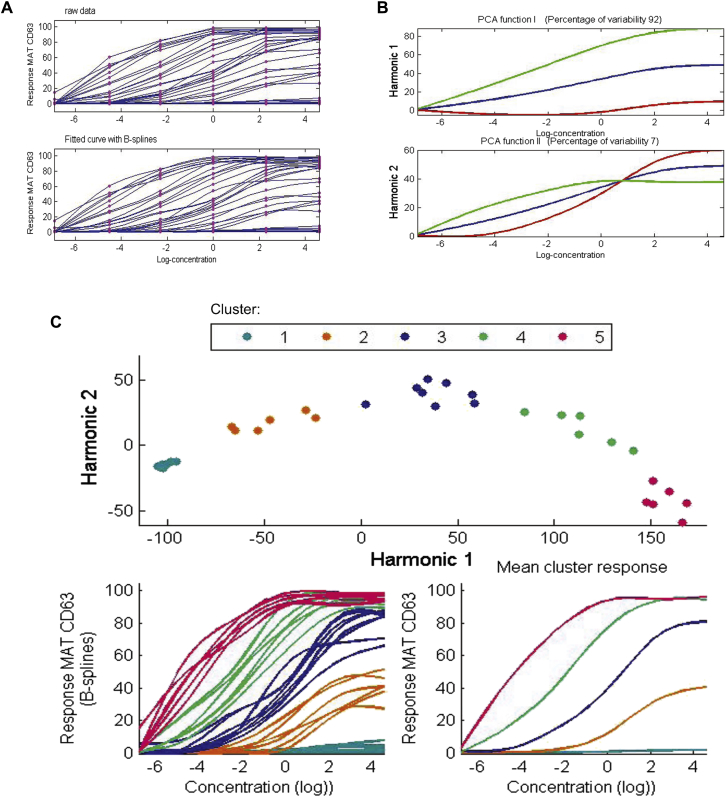
FDA of the MAT. A, Raw data and smoothed curves for peanut-sensitized subjects (n = 42). B, Principal components analysis (PCA) of pattern response measured by using the MAT assay. Lines show the effect of adding (green line) or subtracting (red line) 2 SDs from the mean response curve (blue line). C, Distinct clusters of allergic responses to peanut obtained through k-means on FPC scores.